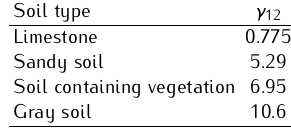
Table 7. Relationship between K